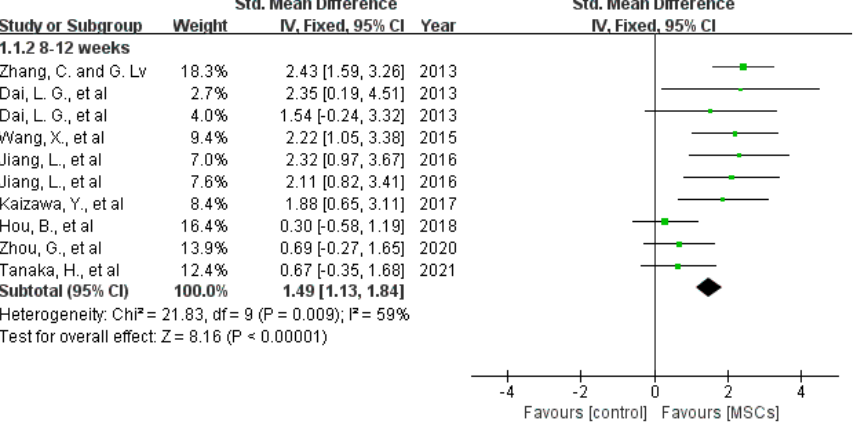
Figure 5. Meta-analysis of the effects of MSCs on nerve conduction velocity 8–12 weeks after implantation [5,11–36]. Plots on the right-hand side indicate favoring MSCs or MSCs-loaded scaffolds, while plots on the left side indicate favoring placebo-control treatment or blank scaffolds.